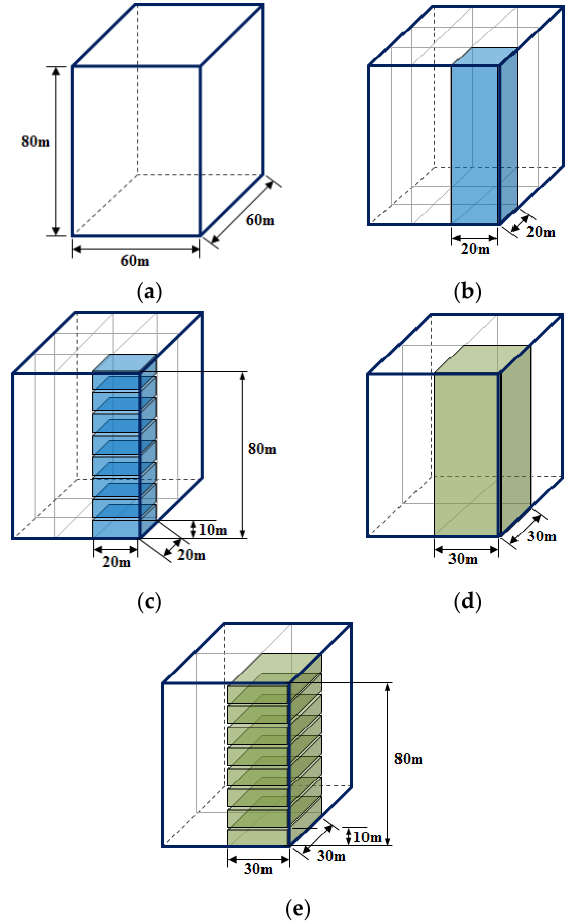
Figure 3. Illustration of voxel and sub ‐ voxel configurations. ( a ) 60 m × 60 m × 80 m voxel; ( b ) 20 m × 20 m × 80 m sub ‐ voxels (SVs); ( c ) 20 m × 20 m × 10 m SV1 to SV8; ( d ) 30 m × 30 m × 80 m SVs; ( e ) 30 m × 30 m × 10 m SV1 to SV8.